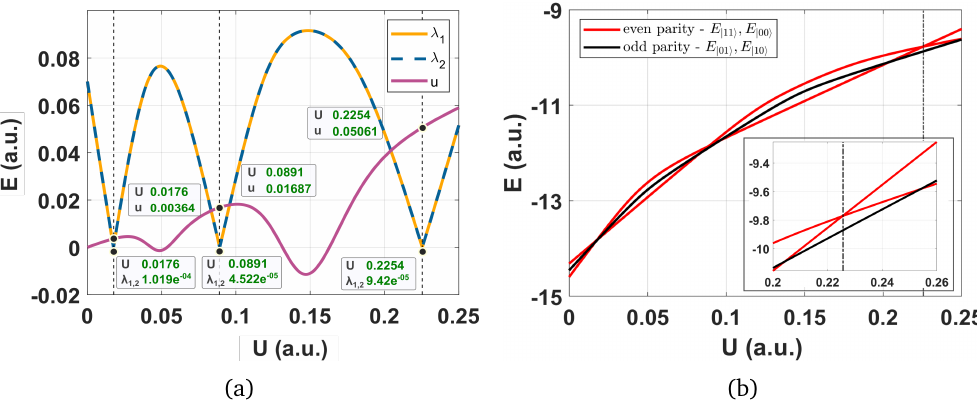
Figure 6: The SYK point parameters obtained for a N = 10 site fermion Kitaev chain = 4, n = 7) obtained using a hybrid genetic model (non-topological segment: n nt 1 nt 2 = 0.5871, algorithm search as described in Section 5.2 are: t = 0.3229, ∆ = 0.1, µ t1 µ = 0.5871, µ = 6.3944, U = 0.2254. (a), We sweep across U fixing the other t2 nt parameters so as to meet the best SYK point at U = 0.2254. We find three SYK points at U = 0.0176, U = 0.0891 and U = 0.2254. At the best SYK point, i.e. at (cid:39) 9.42 e − 5 and u (cid:39) 0.05. (b), We plot the lowest four U = 0.2254, we have λ , λ 1 2 energy levels vs U labelled by their parities (even-red, odd-black). At the SYK point obtained (shown in inset), we find that the two even and the two odd parity states are degenerate (level-crossings) while the energy gap between between different parity states is at a